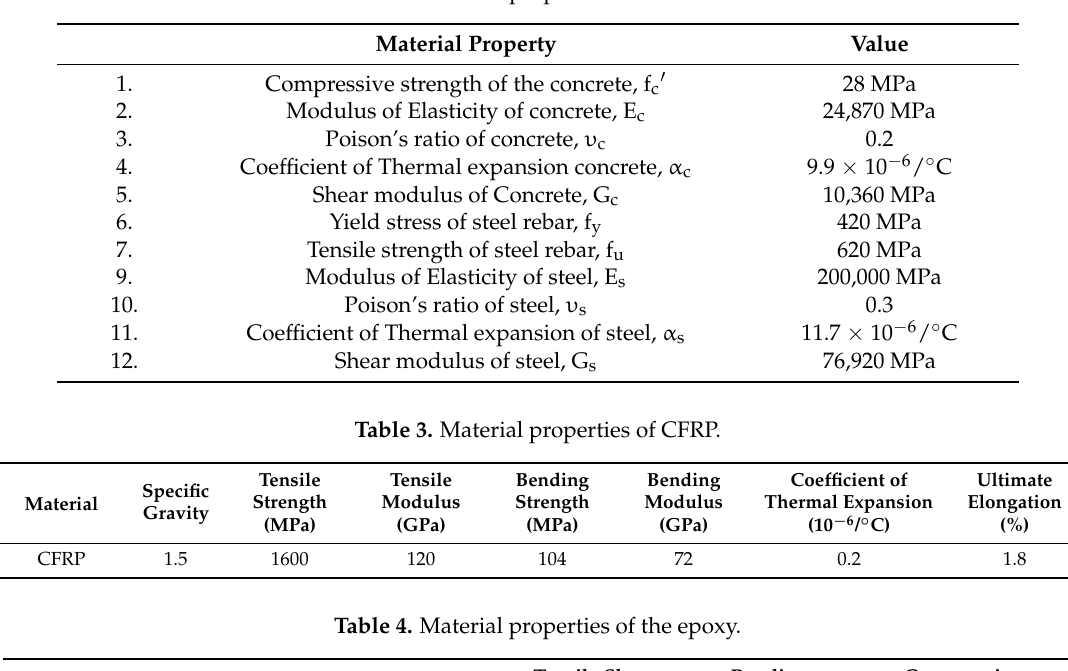
Table 2. Detailed material properties of concrete and rebar.